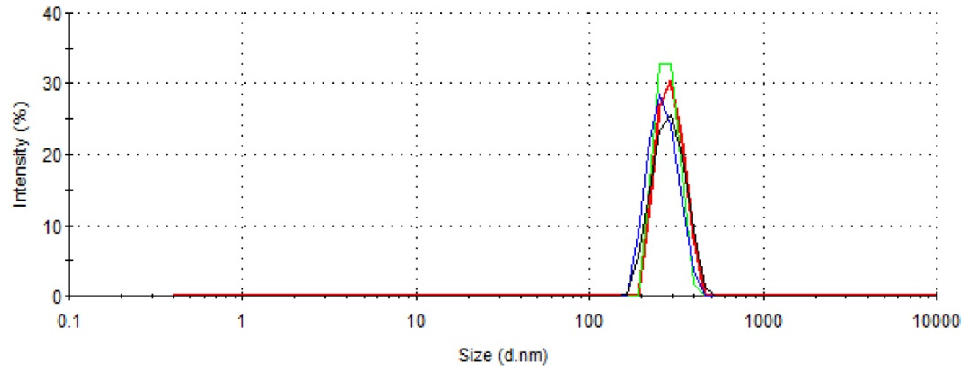
Figure 1. Size distribution of PLA-NPs using DLS technique. NPs were prepared by a nanoprecipita- tion process in one single step without using